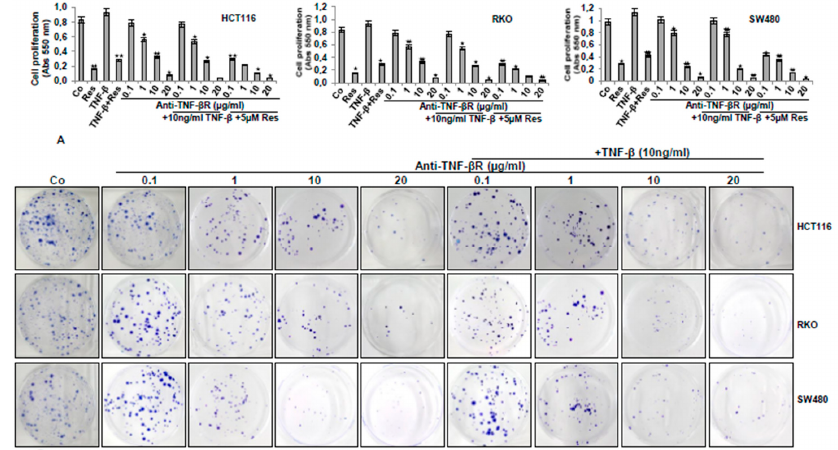
Figure 5. Resveratrol or anti-TNF- β R blocks TNF- β -induced proliferation, migration, and colony formation of CRC cell lines. ( A ) Suppression of the proliferation of CRC cells by resveratrol or anti-TNF- β R, as shown by MTT. CRC cells in alginate culture were untreated (Co) or treated, as described in Materials and Methods. The results were provided by at least three individual experiments. Values were compared with the control, and statistically significant values with p < 0.05 were designated by an asterisk (*) and p < 0.01 were designated by two asterisks (**). ( B ) Suppression of CRC cell migration and motility by anti-TNF- β R. The migration-based cell motility alginate culture was used to define the relative cell motility of the three CRC cell lines, as described above. After 14 days, migrated cells developed colonies on the bottom of petri dishes and they were fixed and labelled with toluidine blue. Typical alginate culture dishes indicated reduced colony formation by anti-TNF- β R dose-dependently, with or without TNF- β